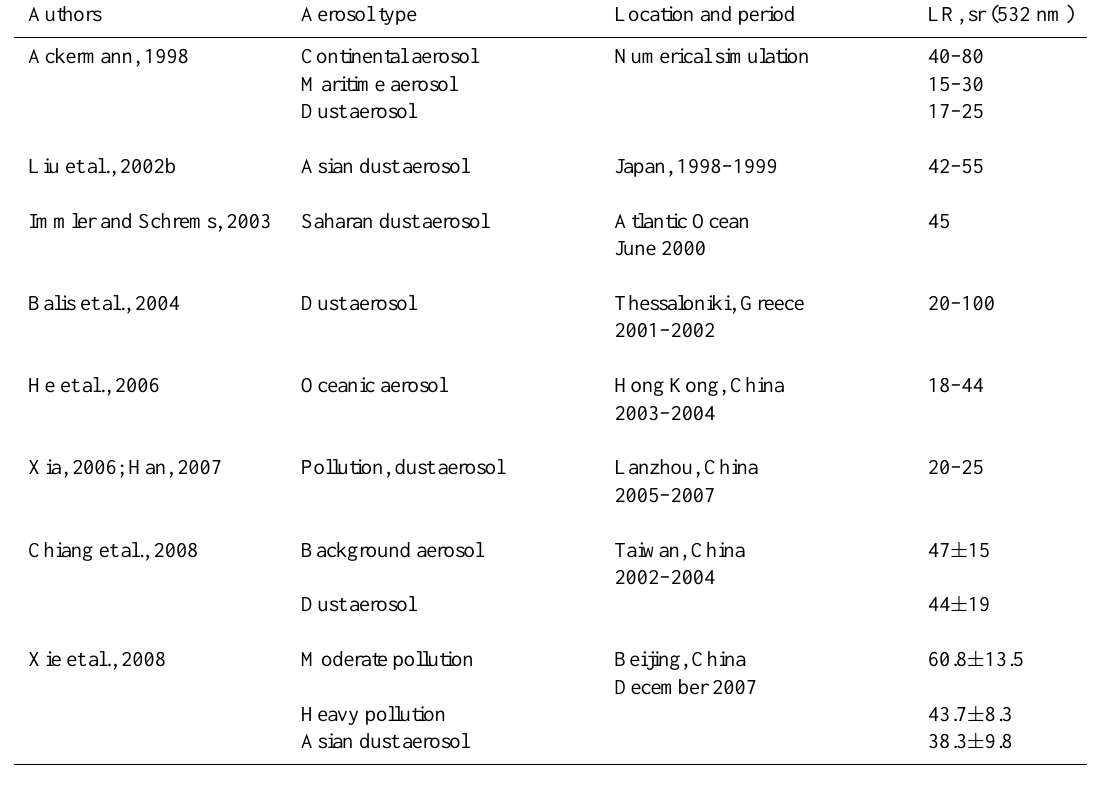
Fig. 1. Location of the Semi-Arid Climate and Environment Observatory of Lanzhou